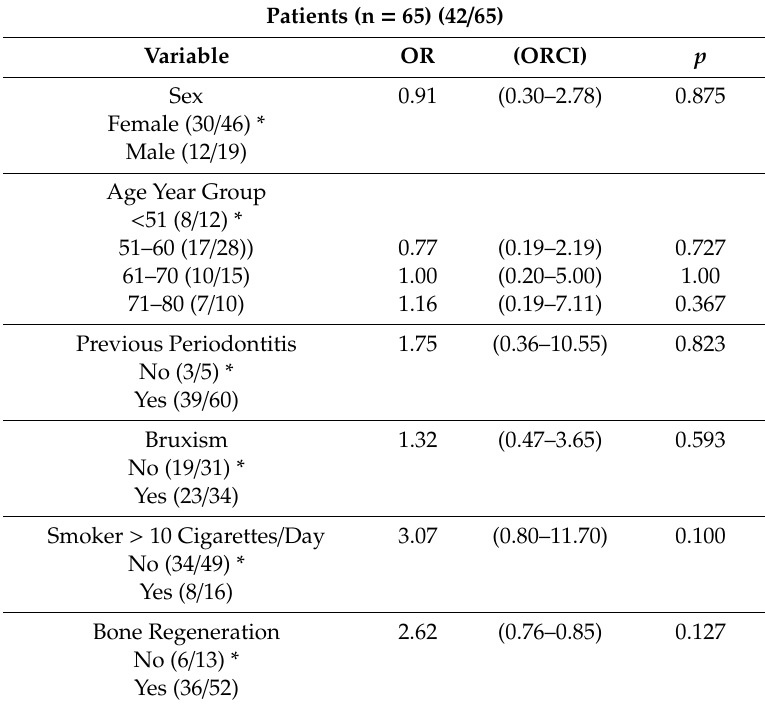
Table 1. Distribution of mucositis complications in the sample in relation to patient-based